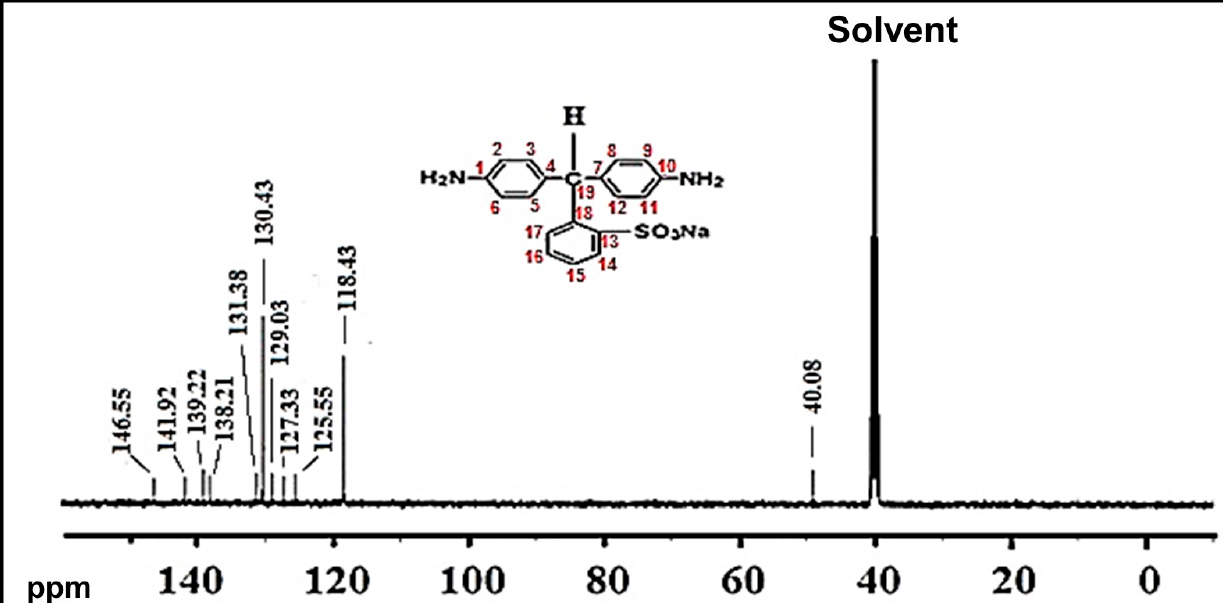
Figure 3. 13 C NMR of a novel sulfonated diamine (NSDA).